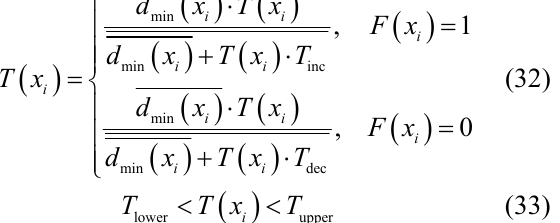
Table1 Test sequences in our experiments.